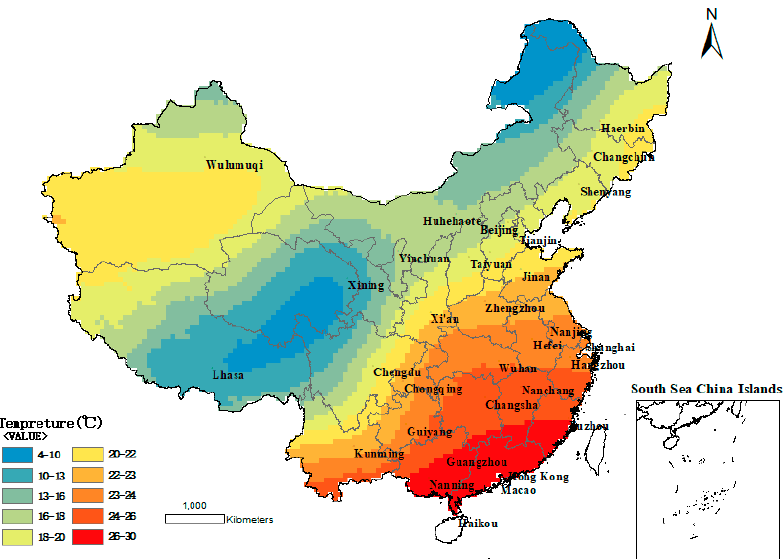
Figure 4. China benchmark equivalent temperature map.